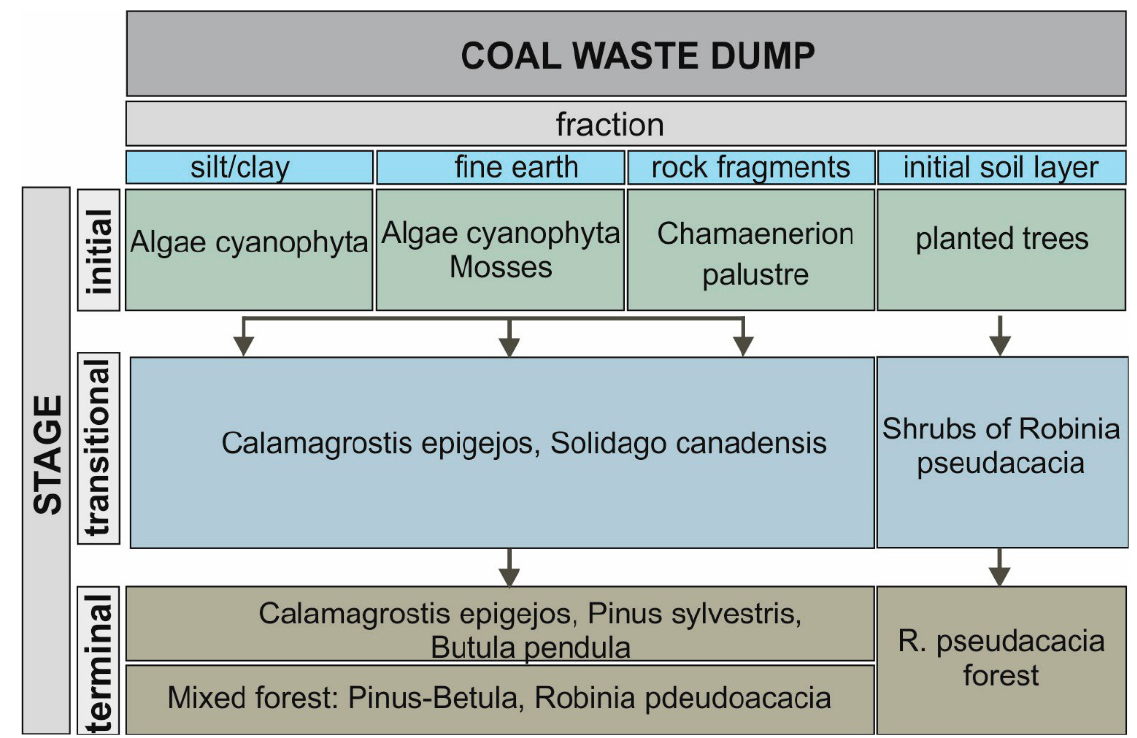
Figure 3. The course of the vegetation succession in the analyzed coal dump.